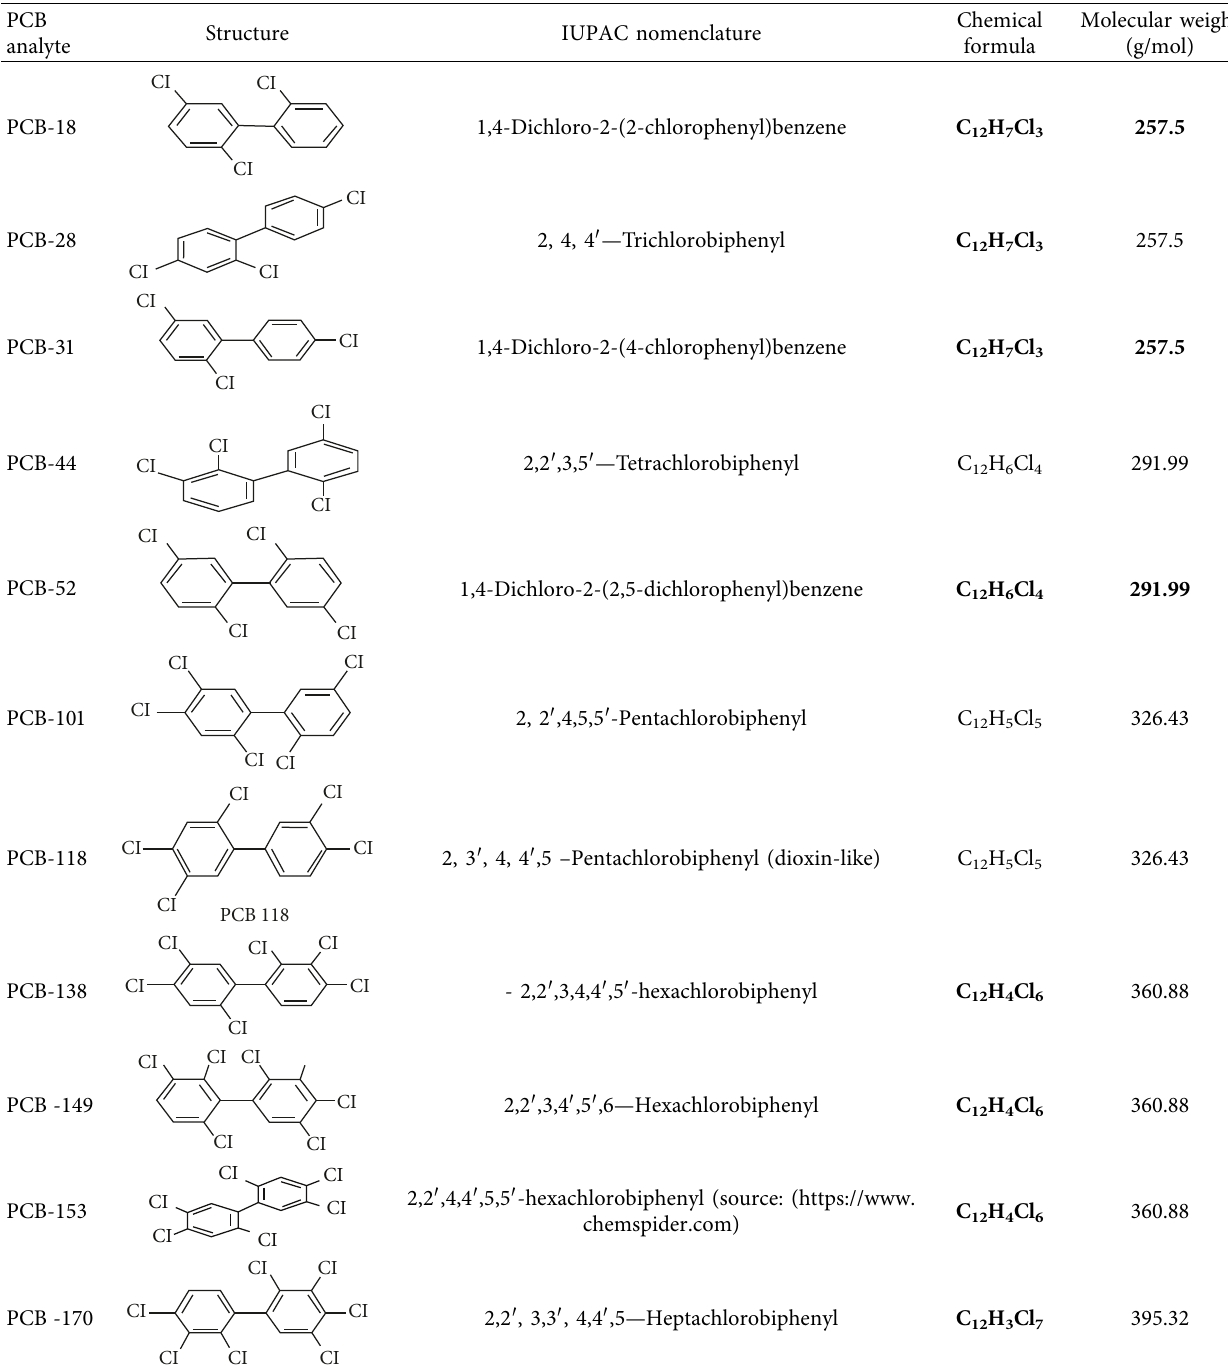
Table 2: Structure and nomenclature of 14 PCB analytes tested